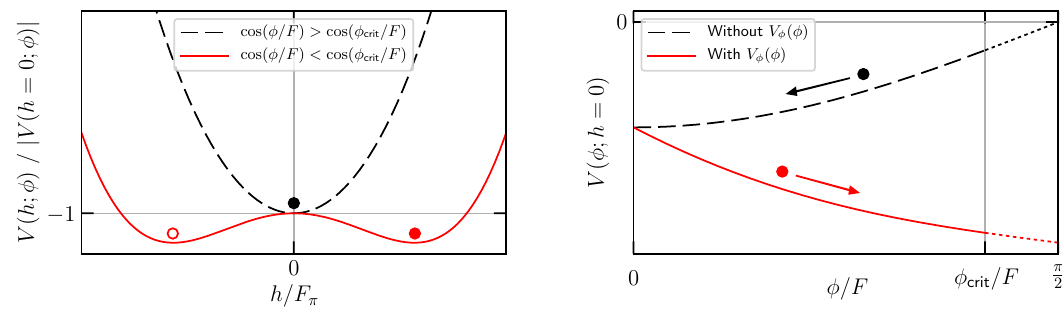
Figure 1 . Left panel: a sketch plot of the potential for the Higgs at (cid:12)xed (cid:30) -(cid:12)eld value, V ( h ; (cid:30) ). For (cid:30) < (cid:30) crit. , the potential V ( h ; (cid:30) ) has a stable minimum at the origin h = 0, yielding an EW- symmetric vacuum (dashed black line). For (cid:30) > (cid:30) crit. , dynamical EWSB is triggered, and the Higgs (cid:12)eld h rolls to a minimum displaced from the origin (solid red line). The dots indicate the stable minima; the EWSB minima are degenerate, and we select h > 0 by convention. Right panel: a sketch plot of the relaxion potential in the EW-symmetric phase, V ( (cid:30) ; h = 0). The solid (red) line shows the potential with the V (cid:30) ( (cid:30) ) term (plotted here for (cid:13) 1; see section 2.3), and the dashed (black) (cid:24) line shows the potential without the V (cid:30) ( (cid:30) ) term [in both cases, the lines are dotted in the region (cid:30) [ (cid:30) crit. ; (cid:25)= 2], as the EW-symmetric ( h = 0) potential is not relevant for the (cid:30) -rolling after EWSB 2 had been triggered]. As indicated by the respective dots and arrows, without the V (cid:30) ( (cid:30) ) term, the relaxion (cid:12)eld naturally wants to roll from its initial value back toward the origin at (cid:30) = 0; with the V (cid:30) ( (cid:30) ) term, the rolling direction is reversed: (cid:30) will roll toward (cid:30) crit. , triggering dynamical